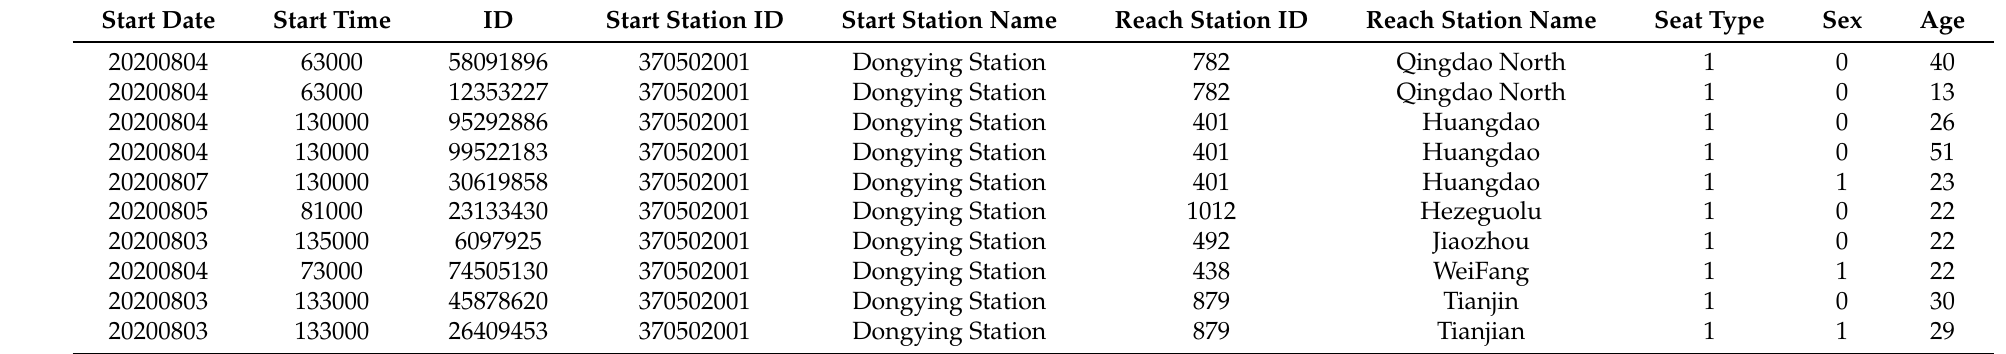
Table 1. Taking Shandong as an example to display the dataset. We only intercepted the first 10